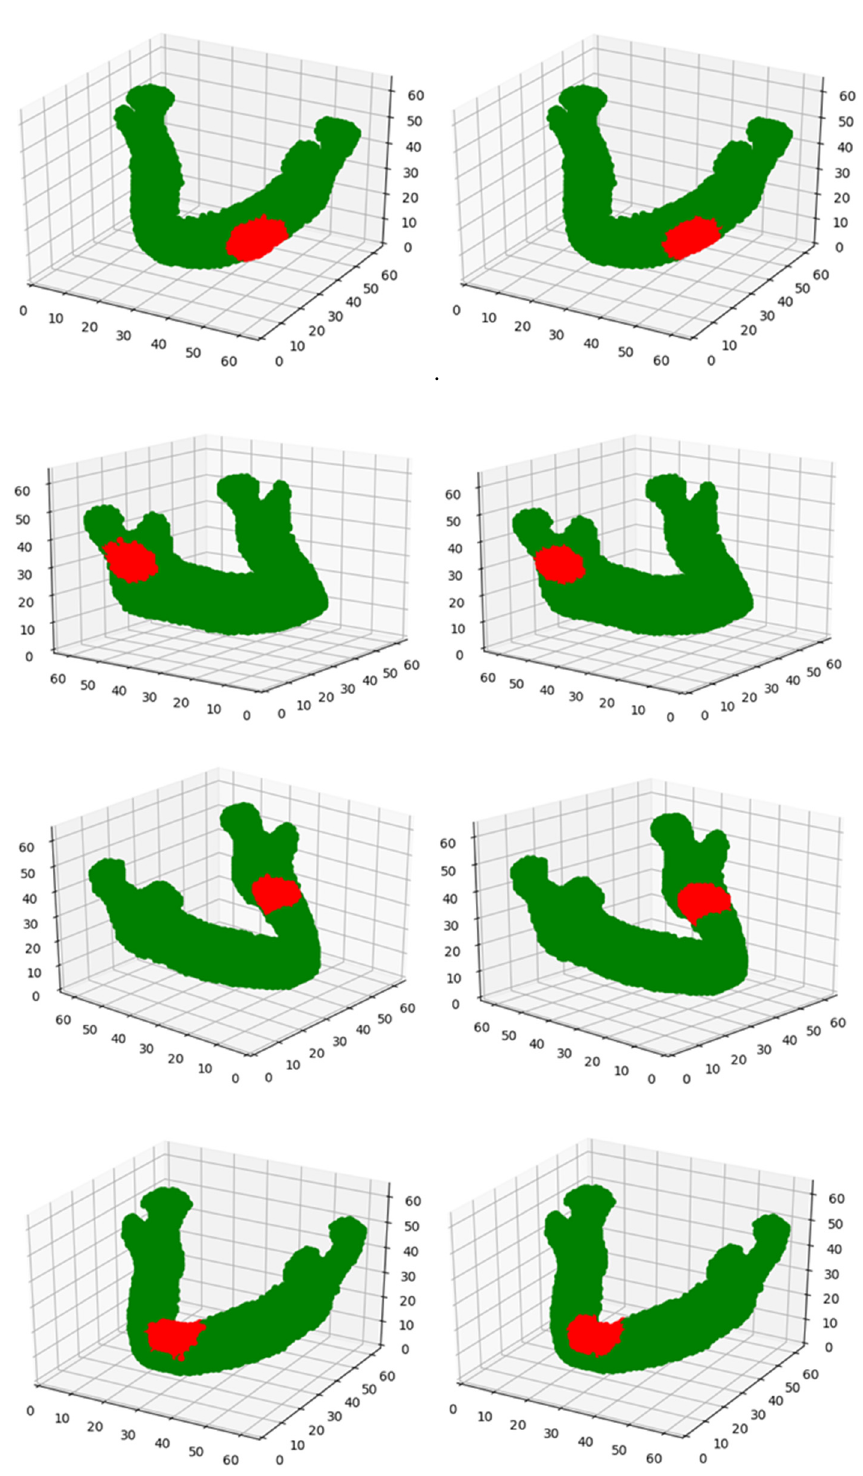
Figure 8. The Visualization of the repaired mandible 3D